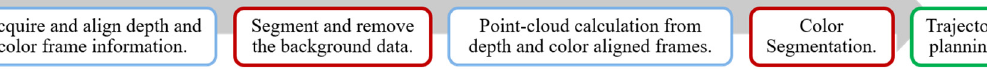
Figure 5. The flowchart of path extraction.